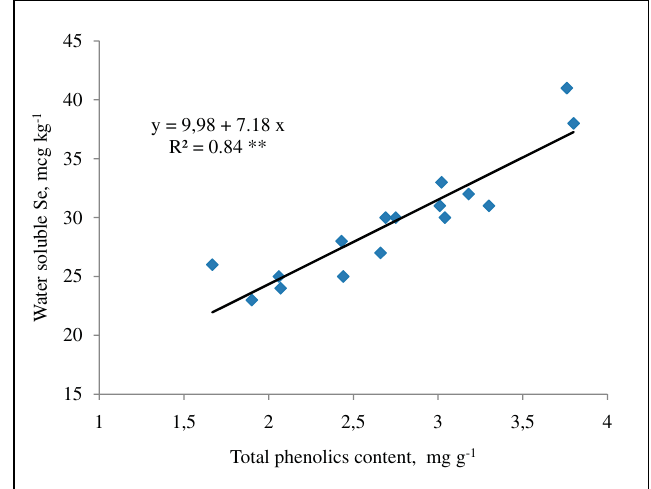
Fig.4 Fig.4 Fig. 4 - Correlation between water soluble selenium concentration and total phenolics in Allium seeds (r = 0.92; P<